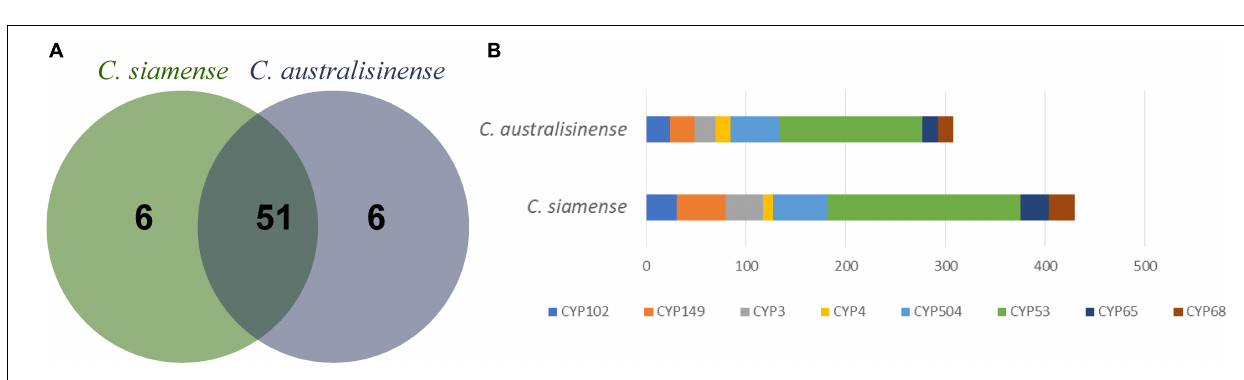
FIGURE 4 | Number of cytochrome P450 monooxygenases gene families (A) and the number of major P450 families (B) in the two Colletotrichum